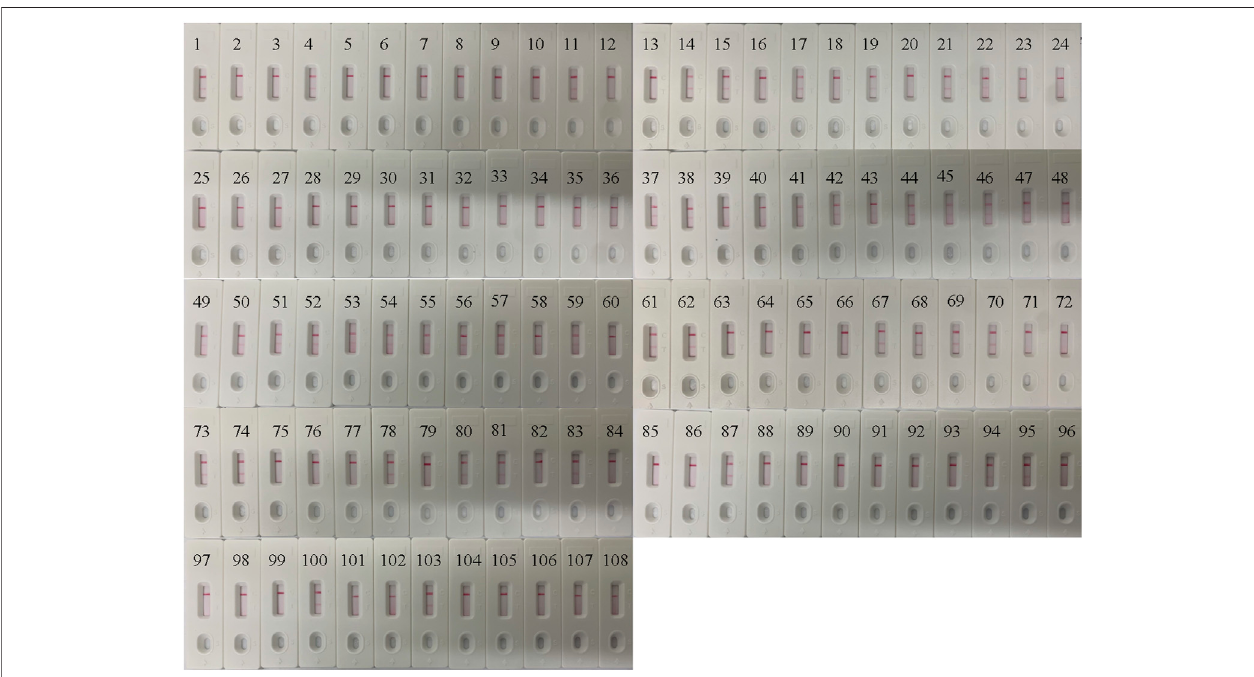
FIGURE 7 | Application of the Bordetella pertussis loop-mediated isothermal ampli fi cation/nanoparticle-based lateral fl ow biosensor (LAMP-LFB) assay in clinical specimens. A total of 108 nasopharyngeal swab (NPS) samples were detected by the LAMP-LFB assay, with the results showing 44 samples testing positive.